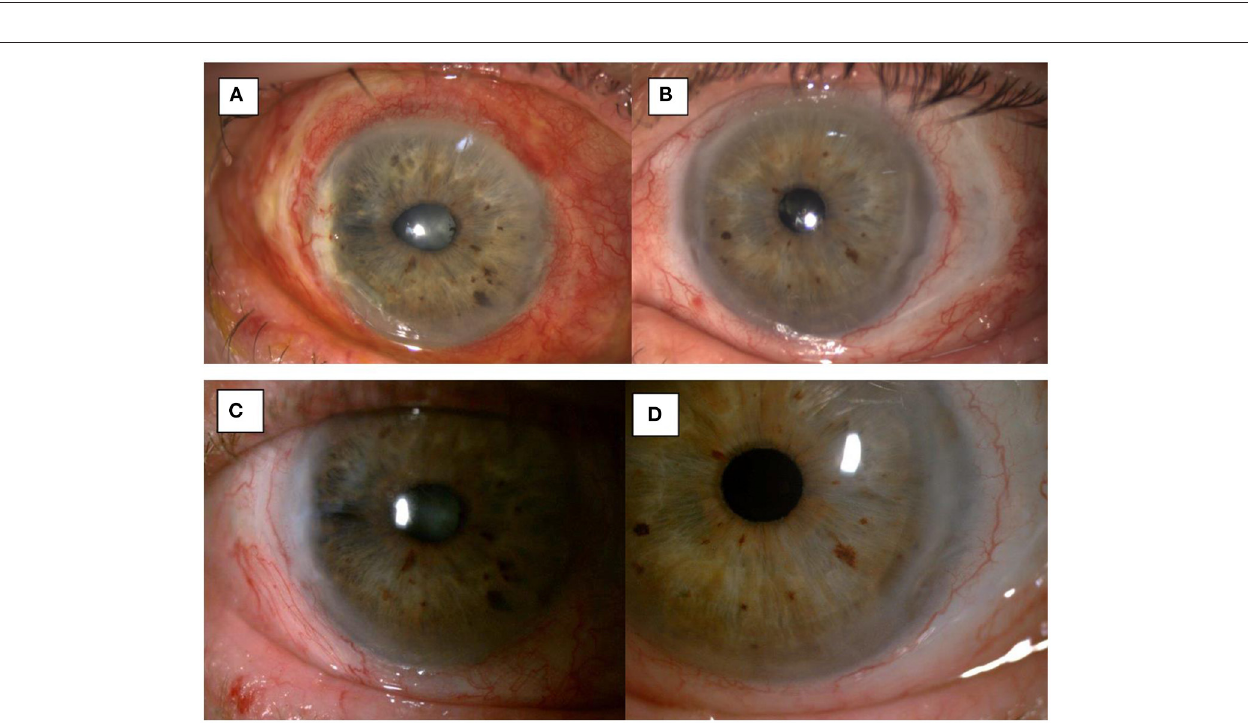
FIGURE 3 | (A) Pre-operative image of the right eye with temporal thinning and perforation, iris prolapse and surrounding inflammation. (B) pre-operative image of the left eye with temporal thinning and surrounding inflammation but no corneal perforation.